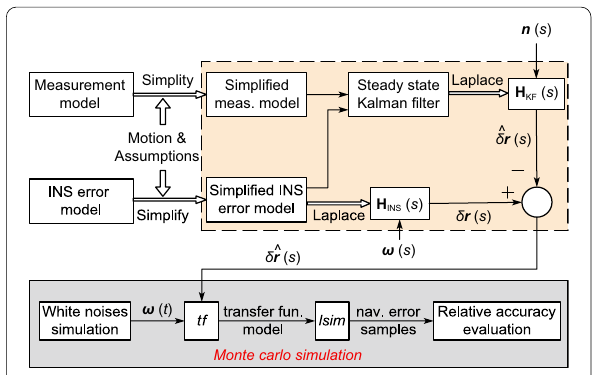
Fig. 2 Flowchart of the semi-analytical analysis of the relative measurement accuracy of the GNSS/INS integrated